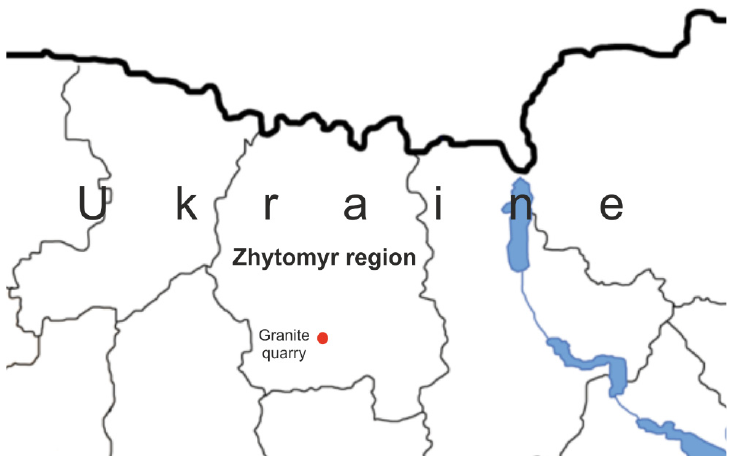
Figure 1. Schematic location of the Pokostovsky quarry (Ukraine).